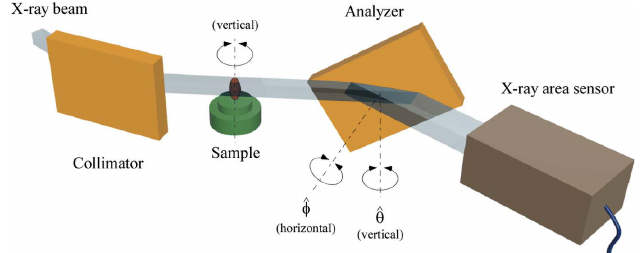
Figure 3 X-ray multi-contrast zooming optics for ABI. The optics consists of a collimator crystal and an analyzer crystal arranged in a nondispersive (+, (cid:2) ) geometry with a sample placed between them. The sample is mounted on a rotation stage for acquiring the CT data set. The analyzer crystal plays an essential role not only as an angular filter but also as a Bragg magnifier with a zoom